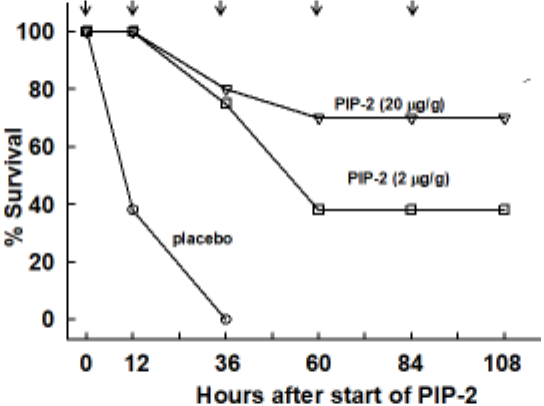
Figure 5. PIP-2 prevents mouse mortality with high dose LPS. Mice were administered LPS (15 µg/g body weight) by intratracheal instillation and divided into two groups. At 12 h after LPS, one group was given PIP-2 in liposomes by intravenous injection (IV) while the other group (placebo) was given liposomes alone. The time of the treatment initiation (12 h after LPS) is plotted as zero time. Treatment was repeated at 12, 36, 60, and 84 h after the initial dose of PIP-2,co-incident with the plotted points. Surviving mice were sacrificed at 108 h. n = 12 for placebo and n = 11 for PIP-2. with new Figure 5.